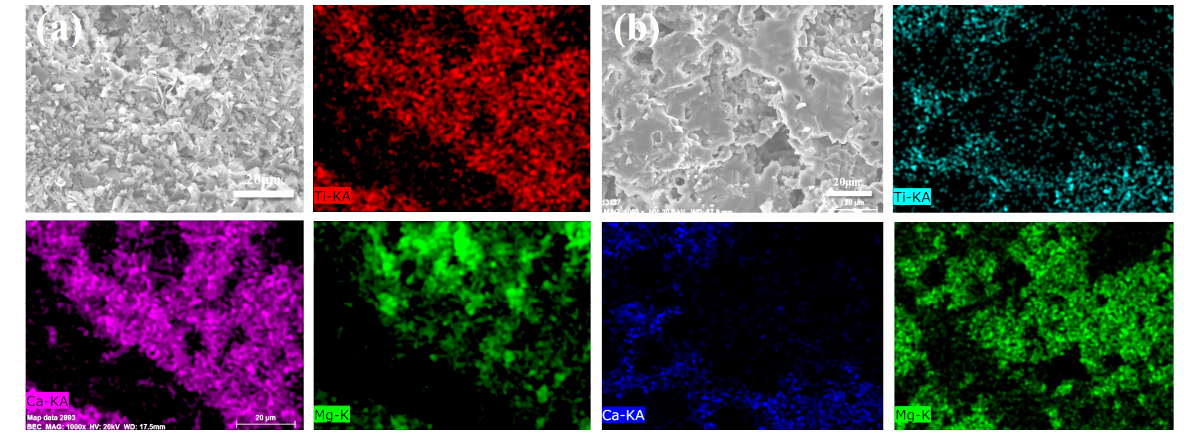
Figure 4. Titanium, calcium, and magnesium distribution in specimens after calcination at 1450 °C for 3 h: ( a ) MT2 and ( b ) CT2.